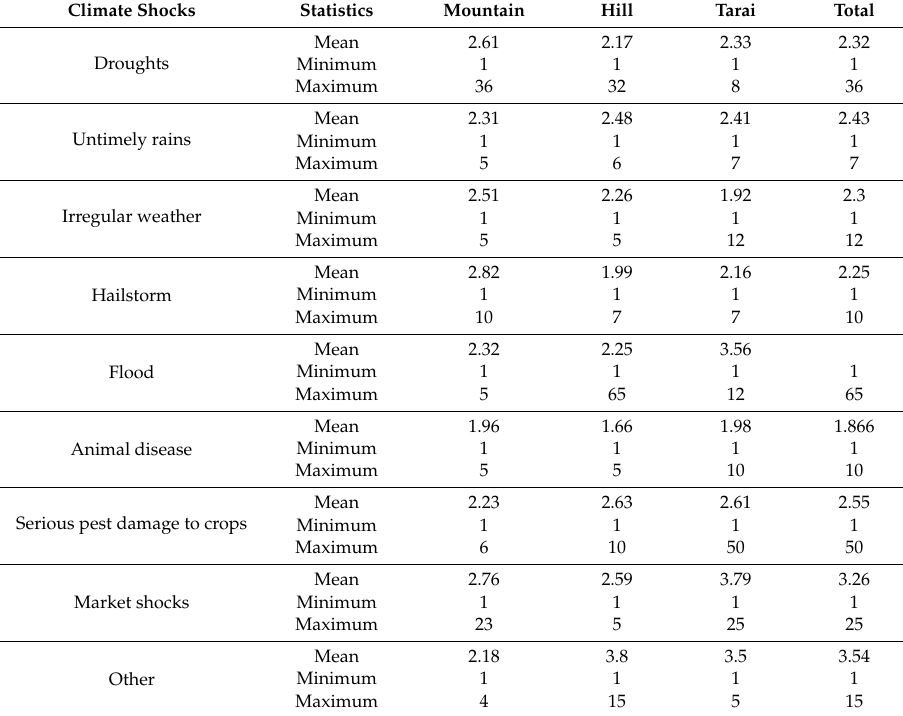
Table A2. Frequency of climate shocks across the